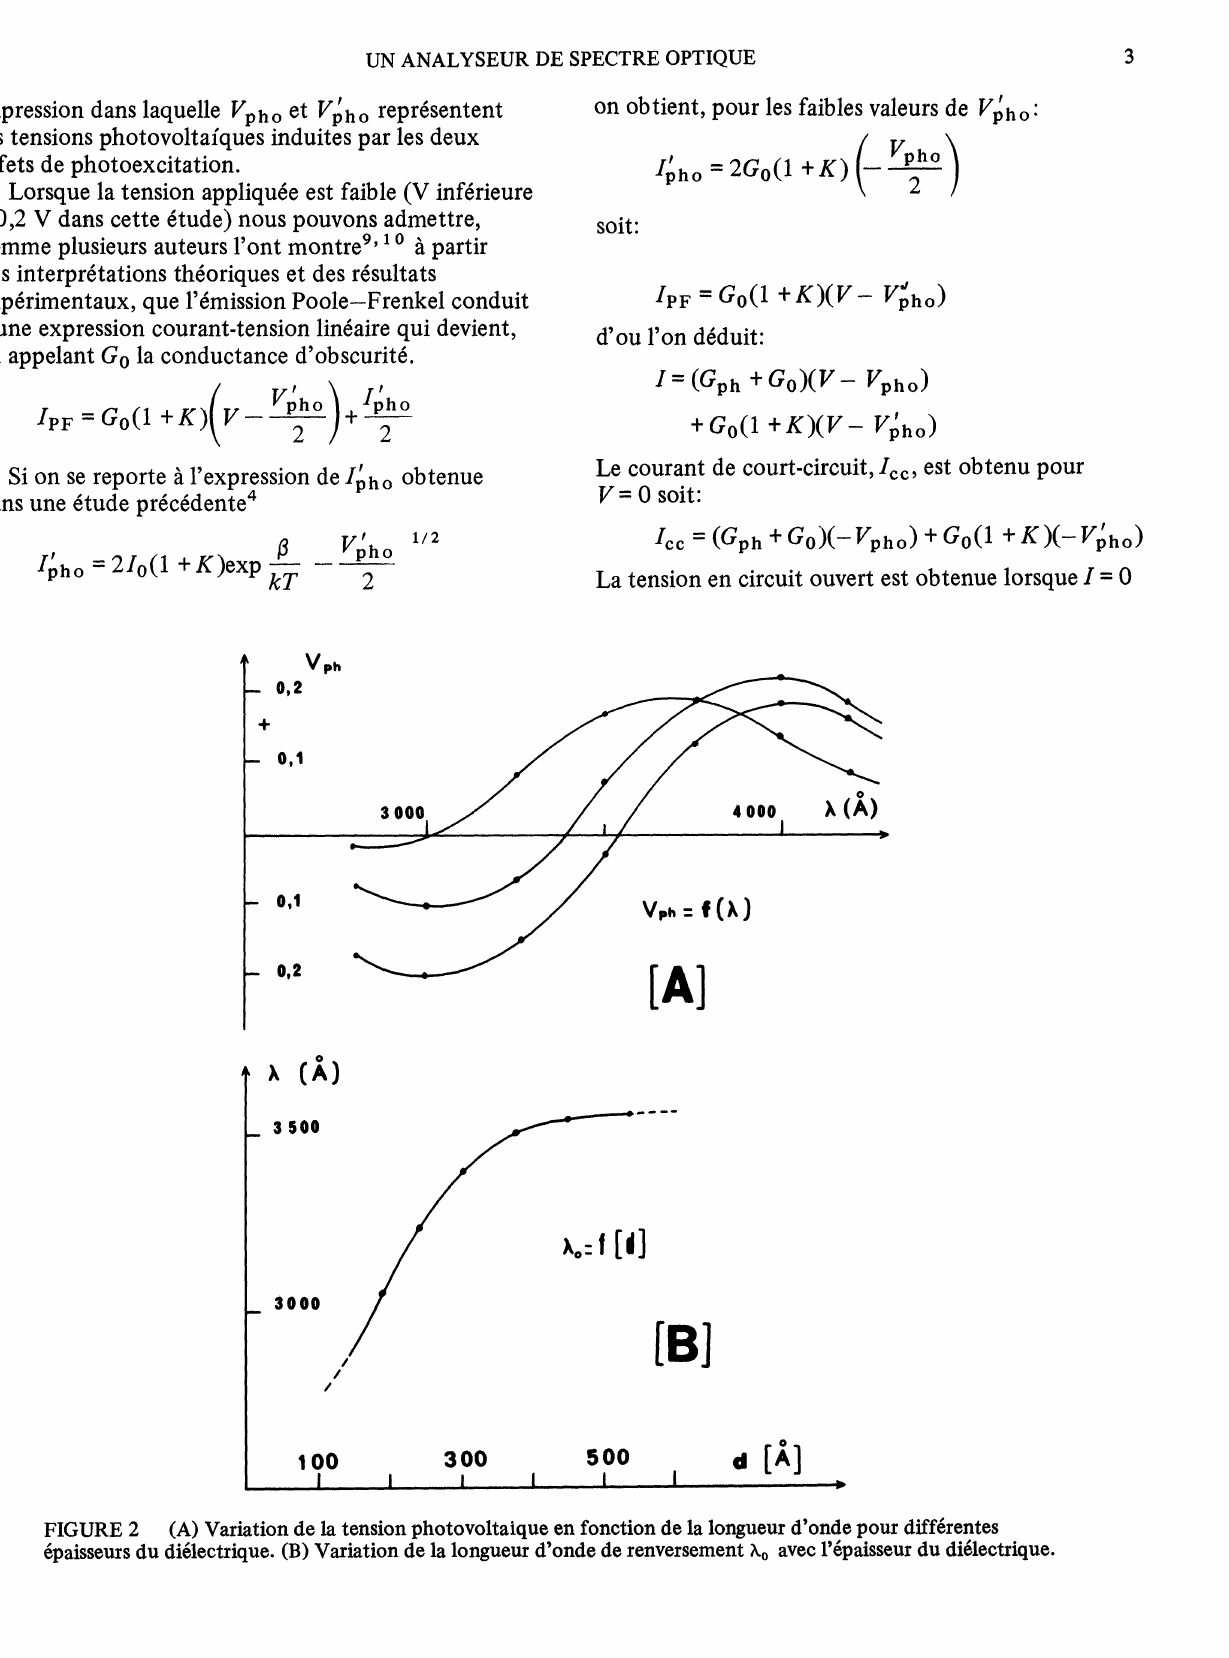
FIGURE 2 (A) Variation de la tension photovoltaique en fonction de la longueur d’onde pour dfff6rentes 6paisseurs du di61ectrique. (B) Variation de la longueur d’onde de renversement ho avec l’6paisseur du